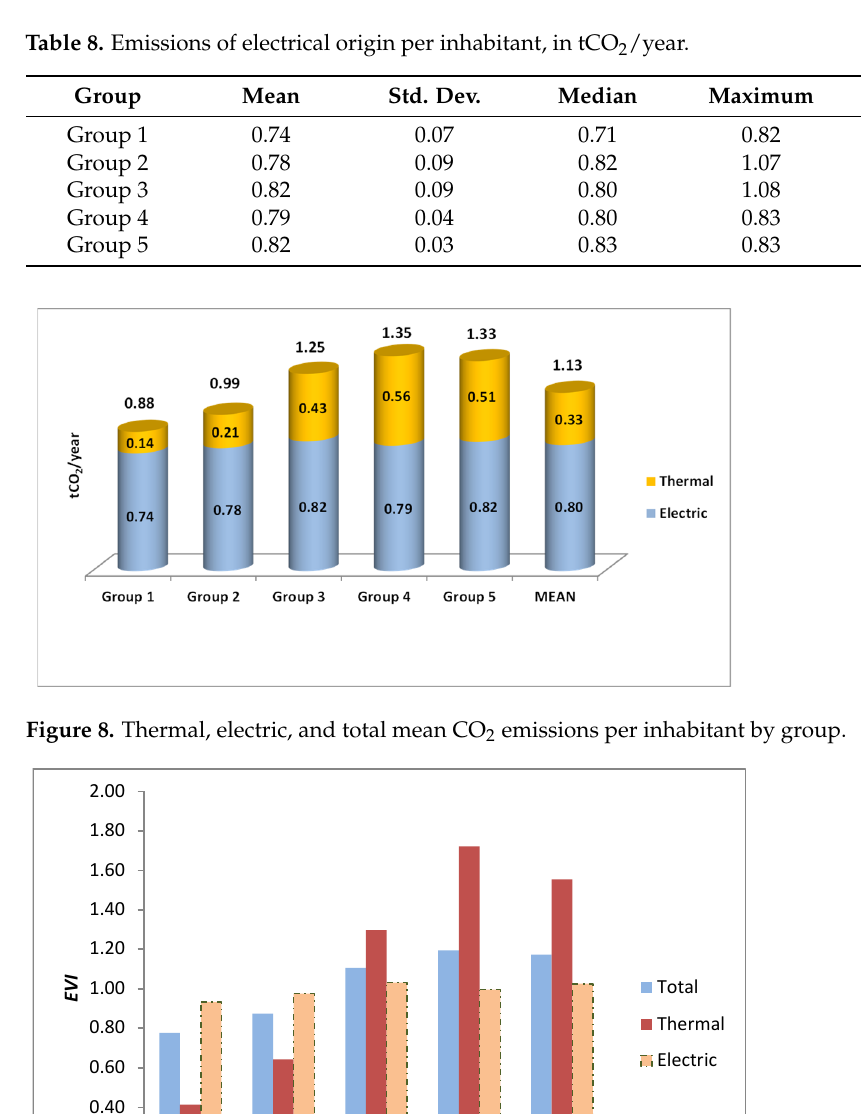
Figure 9. Variation of the EVI index for CO2 emissions per inhabitant by group.